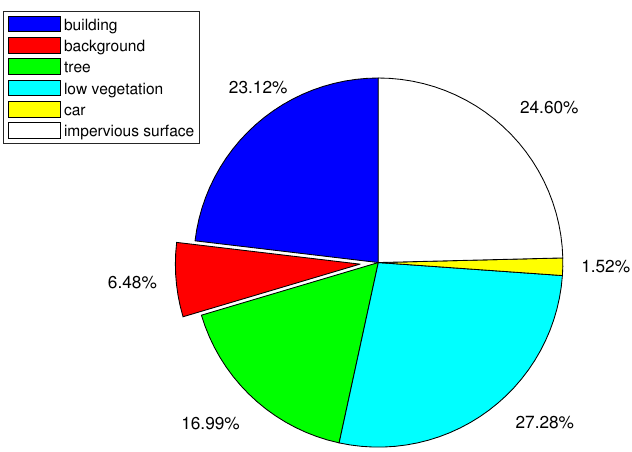
Figure 3. Category distribution of Potsdam test